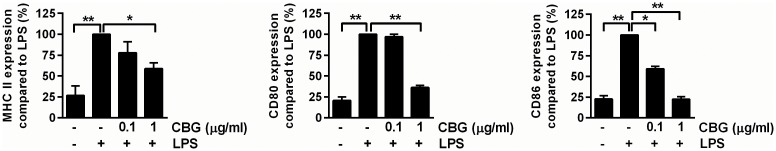
CBG inhibits DC maturation in response to LPS stimulation.DCs were stimulated with LPS (100 ng/ml) in the presence of vehicle or CBG for 24 hours. Cells were stained with anti-MHC class II, anti-CD80 and anti-CD86 antibodies and analyzed by flow cytometry. Data shown represent means + SEM of the Median Fluorescence Intensity (MFI), expressed as % compared to LPS alone, for 3 donors. *P<0.05.